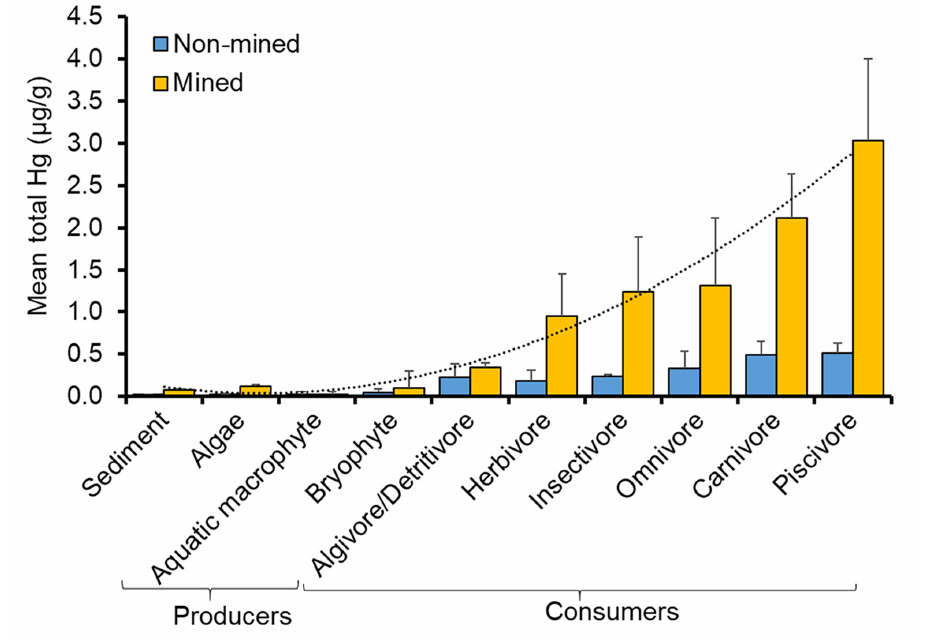
FIGURE 6 | Mean Hg concentrations (dry weight) in sediments and instream biota separated by trophic groups (producers and consumers) between mined and non-mined sites in the Mazaruni River, Guyana. Species were grouped together based on their trophic guild. Polynomial trendline: y = 0.05x2 - 0.22x + 0.28, coefficient of determination R² =